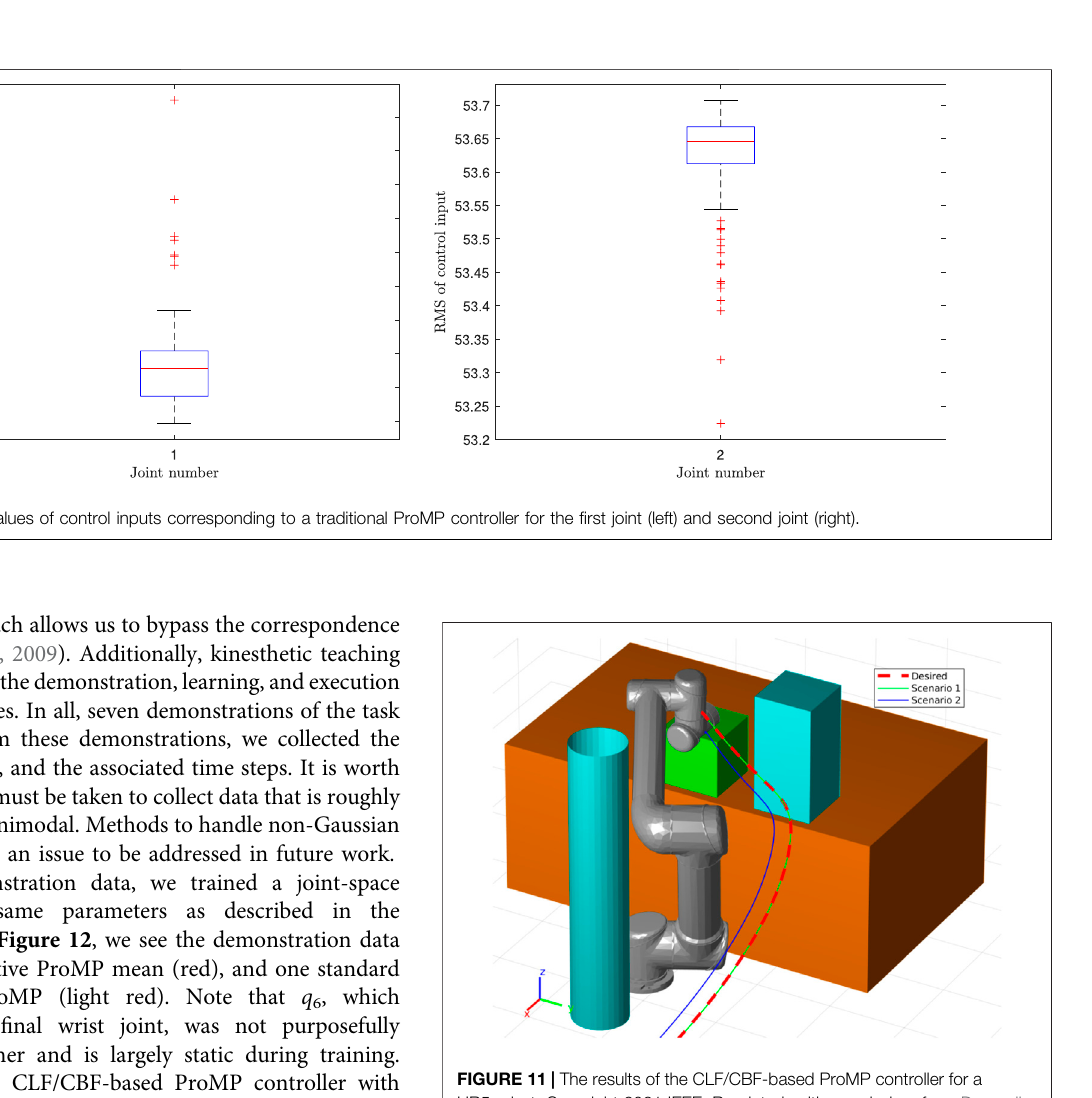
Frontiers in Robotics and AI |